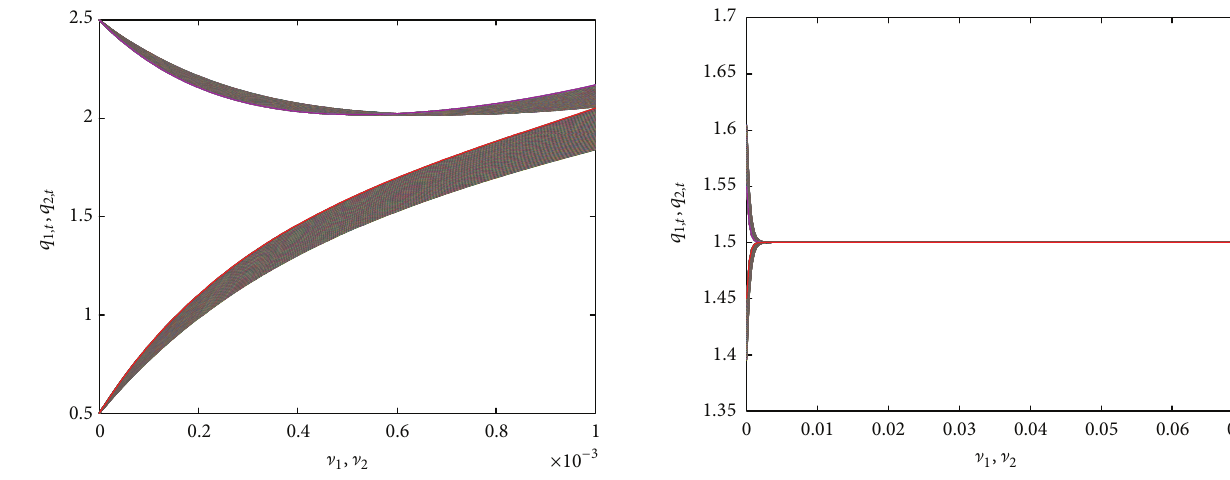
Figure 6: Behavior of 𝑞 1,𝑡 and 𝑞 2,𝑡 at the parameters: 𝑎 = 8 , 𝑐 = 2 , 𝑏 = 1